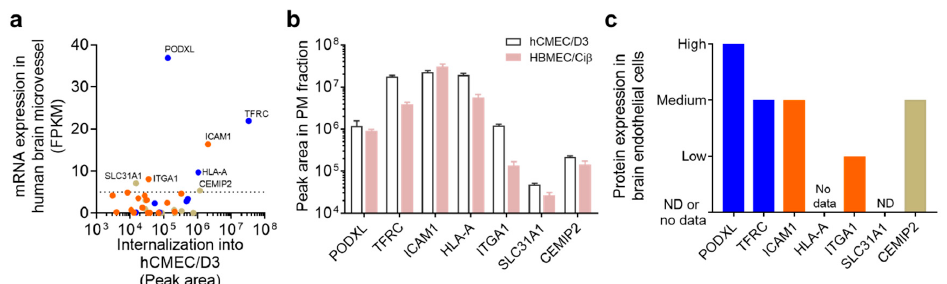
Figure 6. Identification of blood–brain barrier (BBB)-selective biotinylated endocytic cell-surface proteins in human brain microvascular endothelial cells. ( a ) Relationship between the expression of biotinylated endocytic cell-surface proteins in the hCMEC/D3 cells (peak area) and that of mRNA (FPKM) in human endothelial cells; the mRNA data are from the open database of mRNA expression levels in human endothelial cells [21]. ( b ) Comparison between the peak areas of seven identified proteins in hCMEC/D3 and HBMEC/Ci β cells. These data are from our previously published paper [17]. Each datapoint represents the means ± SD ( n = 3). ( c ) Localization of human brain endothelial cells by immunohistochemistry. These data are from the human protein atlas [19,20]. ND, not detected.